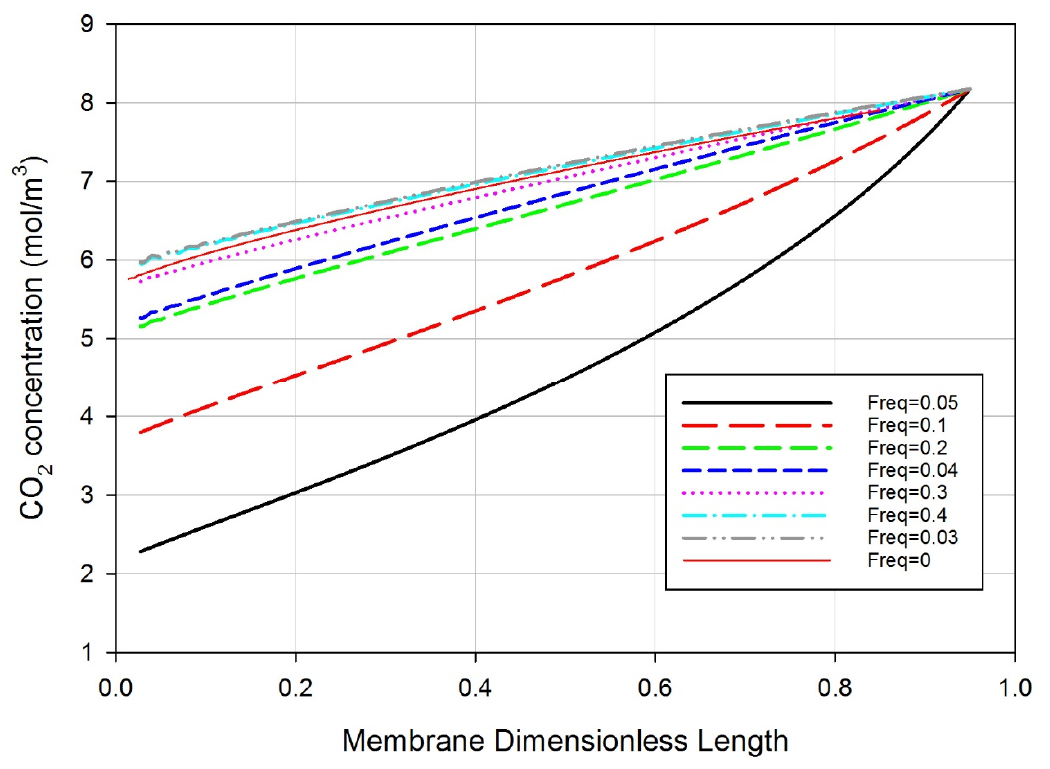
Figure 4. Effect of gas feed oscillation frequency on the CO 2 concentration profile versus membrane dimensionless length of the gas flow on the shell side. Gas feed rate 500 mL/min, liquid feed rate 10 mL/min.